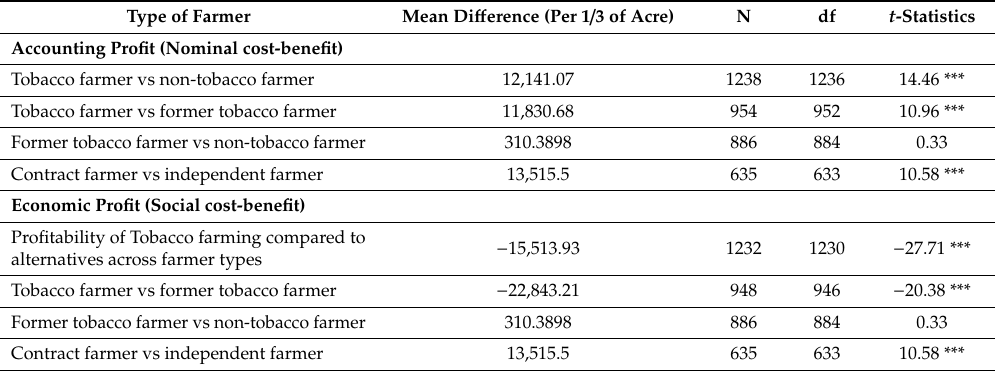
Table 14. Profitability of Tobacco farming compared to alternatives across farmer